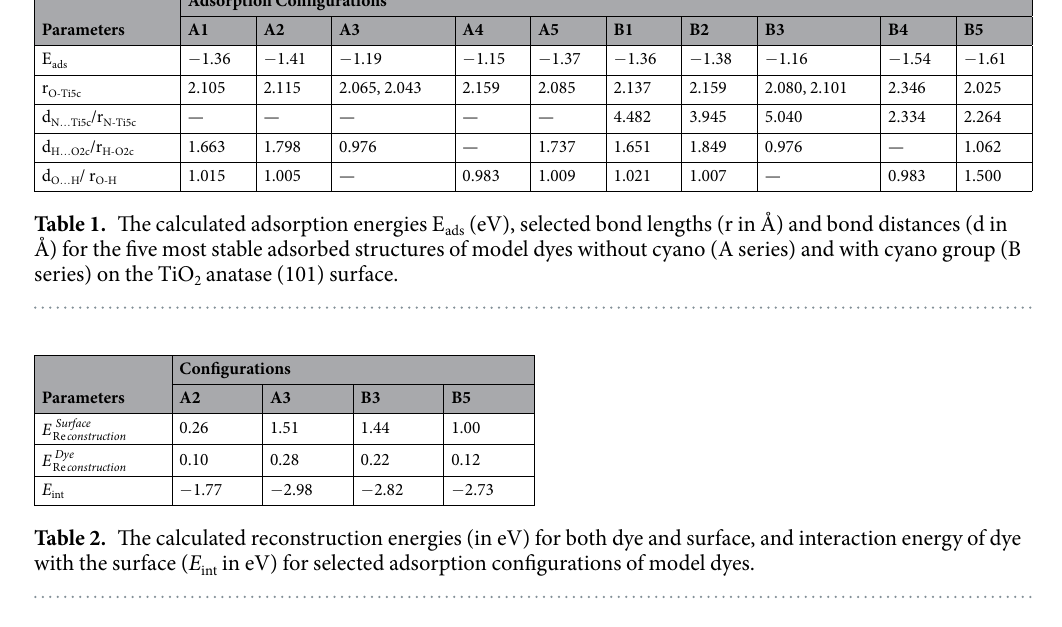
. The obtained EDD plots for configurations 2, 3, and 5 of both A surface & B series are shown in Fig. 3. An increase in electron density between the anchor O and surface Ti 5c atoms has been observed in A2, B2, A3 and B3 configurations. The gain in electrons are more in A2 and A3 configurations than B2 and B3, respectively, which leads the shortening of O-Ti bonds (r O-Ti5c ) by 0.044 Å in A2 and by 0.036 Å in A3 than B2 and B3 configurations, respectively. These results indicate that the substitution of cyano group on the anchoring moiety (B2 and B3) does not improve the electronic interaction between dye and surface. In order to understand the adsorption via cyano group, we obtained EDD plot by cleaving the plane which contains C, O,